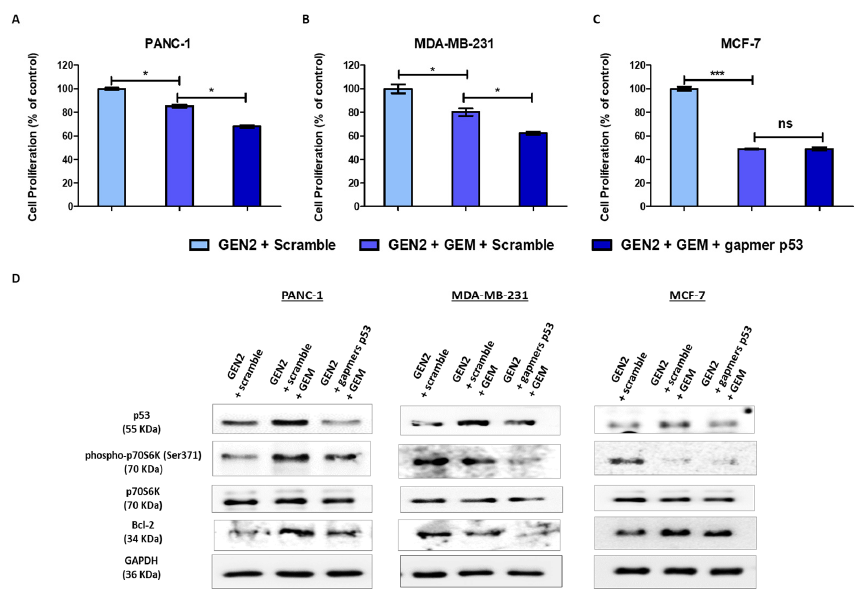
Figure 5. Modified gold nanoparticles reduce chemoresistance in mutant p53 cancer cells. ( A – C ) The indicated cells lines were seeded in 96-well plates, incubated overnight, and treated with GEN2-AuNPs functionalized with 120 pmoles of gapmers against p53. Then, 5 h after the treatment, the cells were treated with GEM (4.5 µ M) incubated for 72 h. At the end of treatment, their viability was assessed. The values of treated cells were normalized to that of untreated controls and reported as mean ± ES. ( D ) The cells lines were seeded in 12-mm diameter culture dishes, incubated overnight, and treated with GEM (4.5 µ M) for 72 h. Whole-cell extracts were processed for Western blot analysis of the indicated antibodies. GAPDH protein level in the same extract was used as a control loading. Statistical analysis was performed using one-way ANOVA (each group vs. control). (*** p < 0.001, * p <